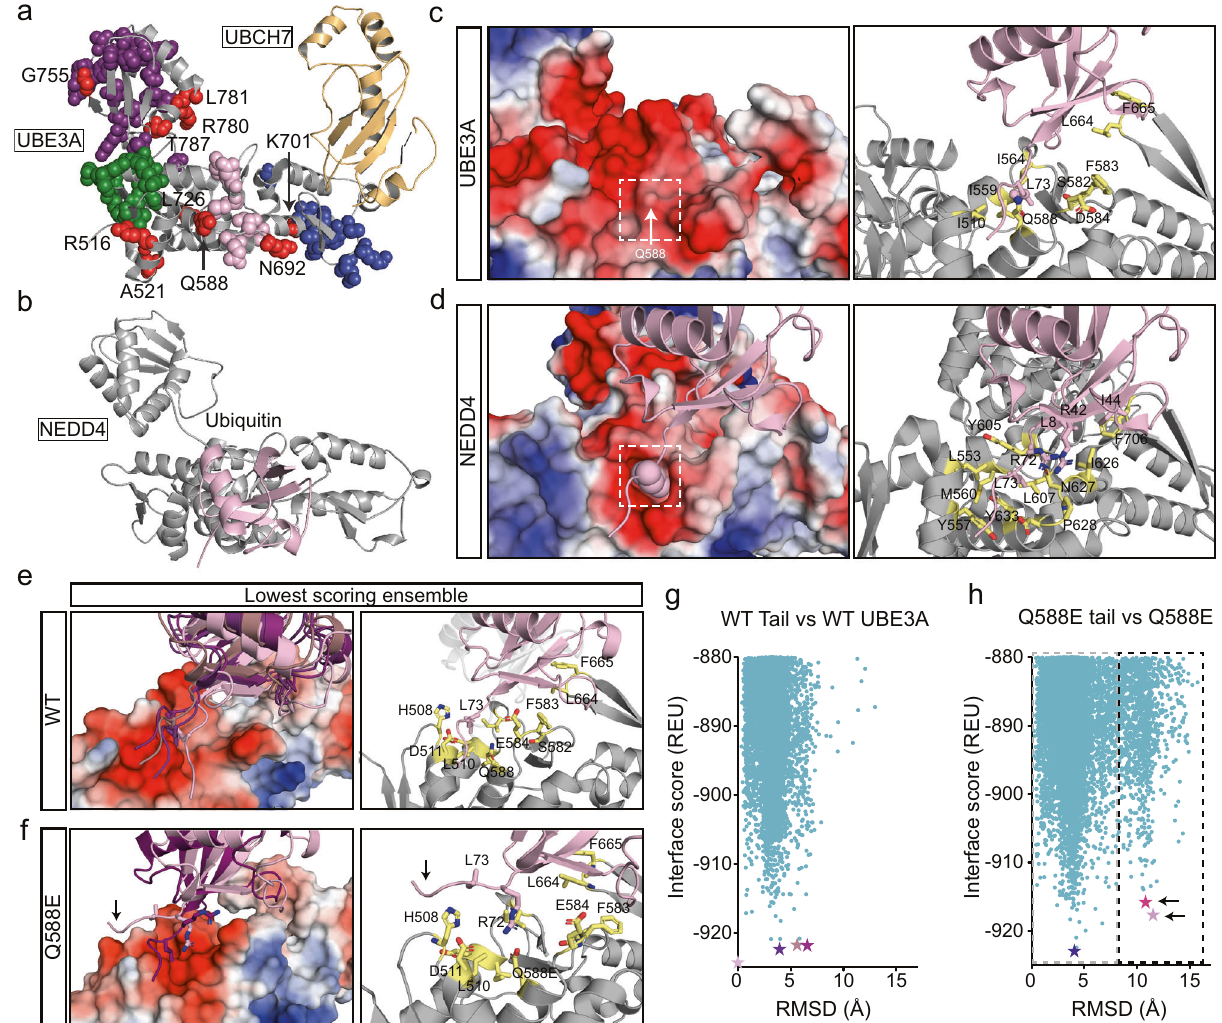
Fig. 4 UBE3A mutations demarcate a ubiquitin-binding exosite. a Crystal structure (PDB: 1C4Z) of the HECT domain of UBE3A (gray) bound to UBCH7 (gold). Mutations identi fi ed in our screen found in the catalytic C-lobe (purple), the E2 binding interface (blue), and two uncharacterized regions (pink and green) are shown. All hyperactivating mutations are shown in red. b Crystal structure of the HECT domain of NEDD4 (gray) bound to a monomeric ubiquitin molecule (pink) at its exosite (PDB: 4BBN). Note the binding of ubiquitin to NEDD4 occurs at a site homologous to a cluster of mutations (pink) in UBE3A. c , d Surface (left) and ribbon (right) representations of the ubiquitin-binding interface for UBE3A ( c ) and NEDD4 ( d ). Ubiquitin is represented in pink. Dotted boxes represent the position of hydrophobic binding pocket in NEDD4 that accepts L73 of the ubiquitin C-terminus. Surface charges are indicated by color: positive (blue), negative (red), uncharged (white). e , f Rosetta simulations showing ensembles of low energy (high con fi dence) conformations for the C-terminus of ubiquitin docked to UBE3A. The divergent orientation of the ubiquitin tail caused by the Q588E mutation in UBE3A is noted by the arrow. g , h Interface score versus RMSD plots showing Rosetta simulations under 880 Rosetta Energy Units (REU). The positions of the low energy models are noted as stars according to the color scheme used in e , f . The gray dotted box demarcates WT-like tail conformations whereas the black dotted box indicates the Q588E tail